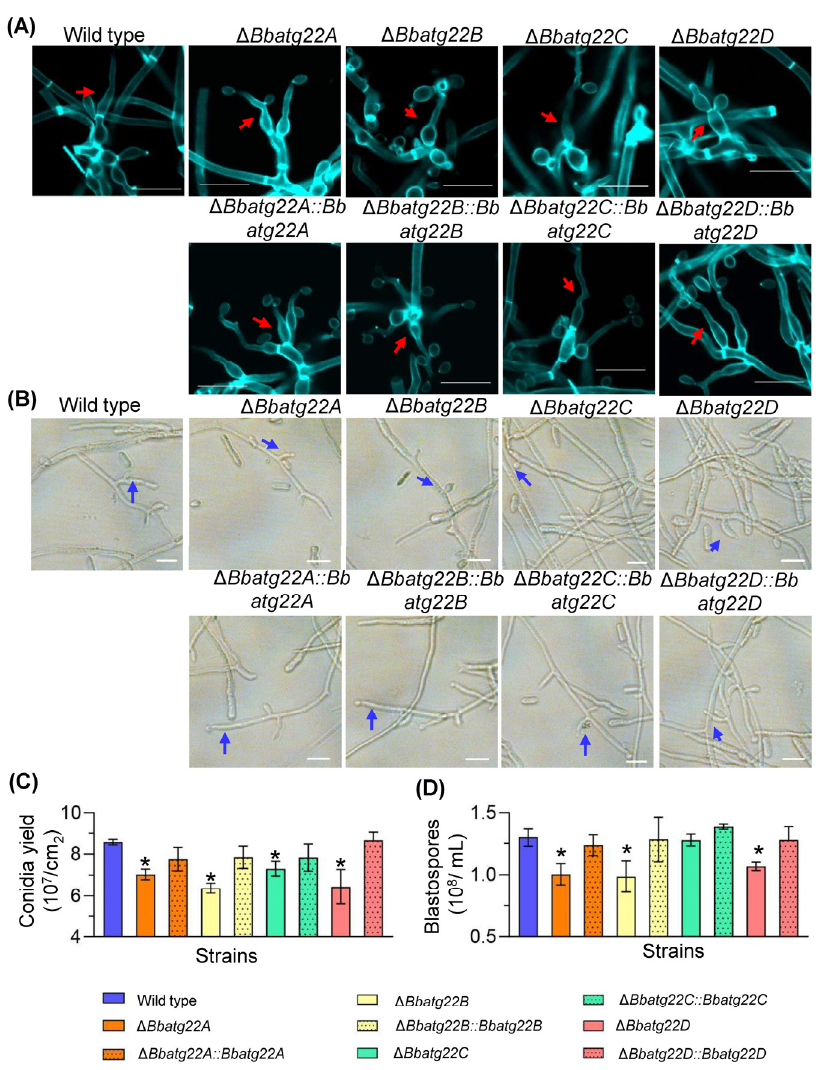
Figure 6. Assays for asexual development in B. bassiana . For aerial development, conidia of the indicated strain were inoculated on SDAY plates and cultured at 25 °C. ( A ) Microscopic view of conidiophores was recorded at 3.5 d post-incubation (dpi). Under submerged condition, conidial suspension were inoculated into SDB and cultured at 25 °C for 3 days, and then blastospore-forming structures were recorded as microscopic images ( B ). Conidial yield was examined at 7 dpi ( C ), and blastospore production was quantified at 3 dpi ( D ). Red and blue arrows indicate the conidium- and blastospore-forming structures, respectively. Scale bars: 10µm.Asterisks on the columns indicate a significant difference between the disruption mutant and the wild type or complemented strains [Tukey’s honestly significant difference (HSD), p < 0.05]. Error bars: standard deviation.